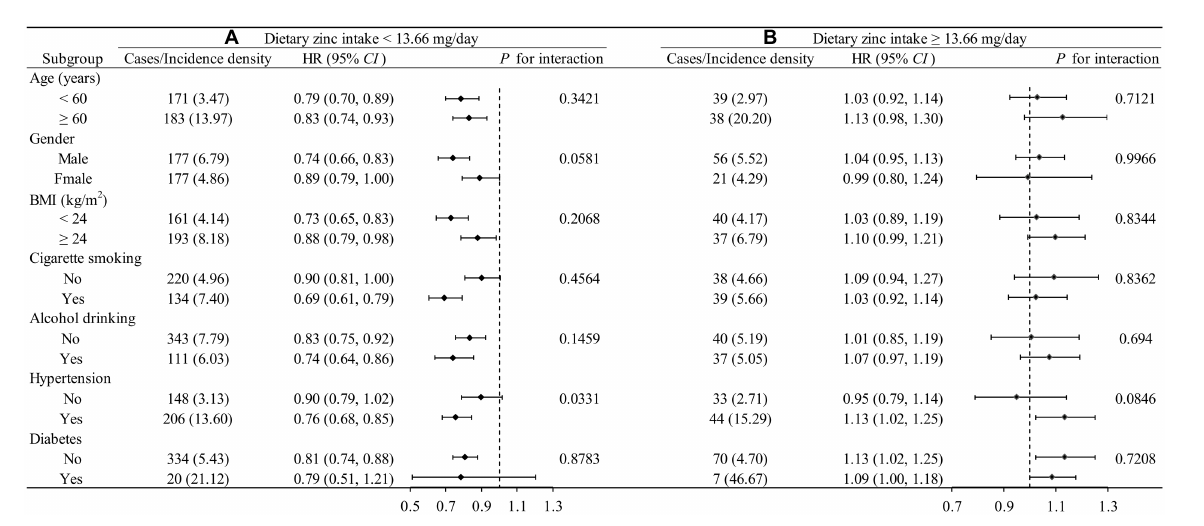
FIGURE 3 Stratified analysis by potential effect modifiers for the association between dietary zinc intake and new-onset CVD in various subgroups divided by 13.662 mg/day. (A) Dietary zinc intake <13.662 mg/day. (B) Dietary zinc intake ≥ 3.662 mg/day. Incident rate is presented as per 1,000 person-years of follow-up. Adjusted, if not stratified, age, gender, race, energy intake, residence, marital status, education level, activity level, smoking status, drinking status, BMI, hypertension, diabetes, dietary fiber, niacin, vitamin C, vitamin E, calcium, iron, selenium, magnesium, copper, and manganese; Incidence density: 1/1000